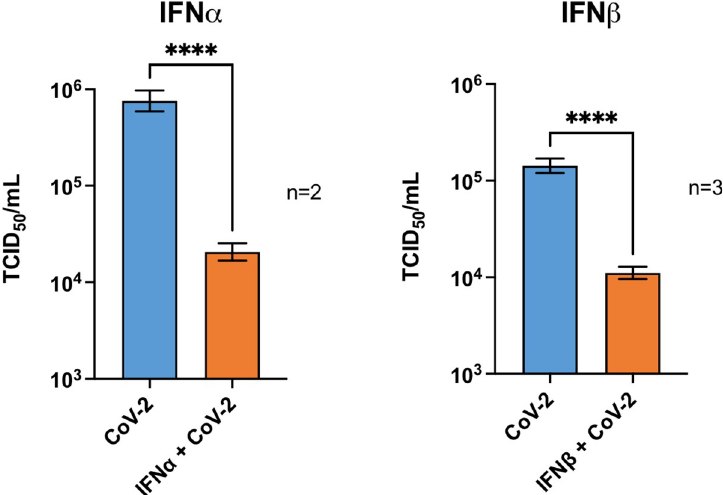
Fig 1. SARS-CoV-2 is responsive to Type-I-IFN anti-viral activity. Vero cells were inoculated at a MOI of 0.01 and after 6-hours were treated with 1000 IU of either IFN α , IFN β , or an equal volume of media alone. 18 hours later, supernatants were harvested for TCID 50 analysis. N = number of repeat experiments performed. In each experiment, 4–6 independent samples per treatment type was measured. Bars represent mean +/- SEM; ���� = p � 0.0001 (Unpaired